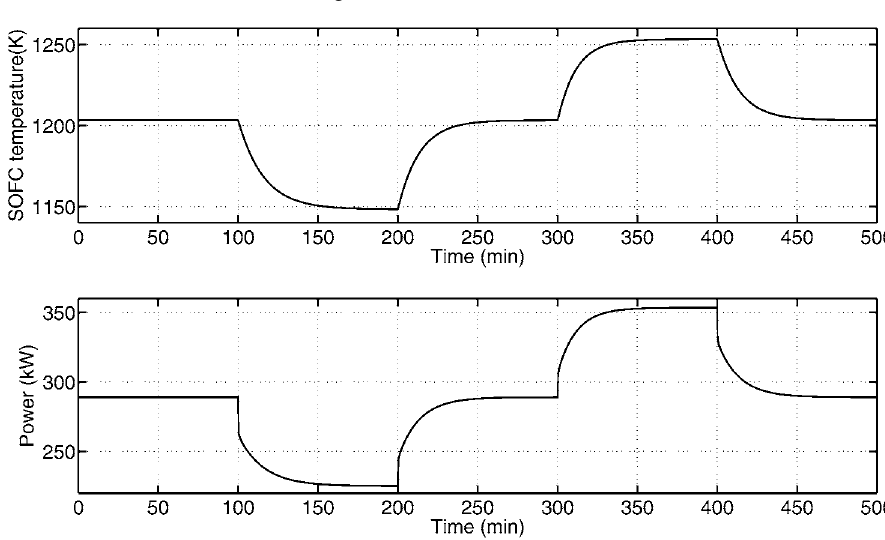
Figure 2. Control structure.